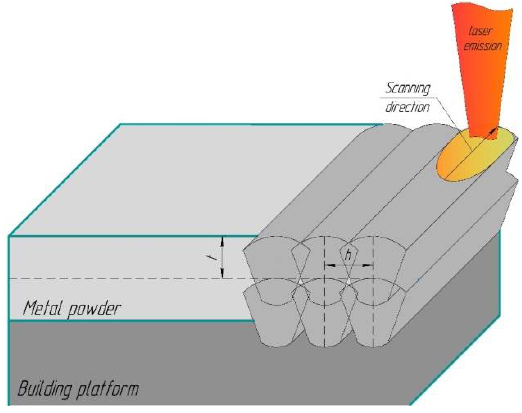
Figure 2. Selective laser melting (SLM) scanning parameters.